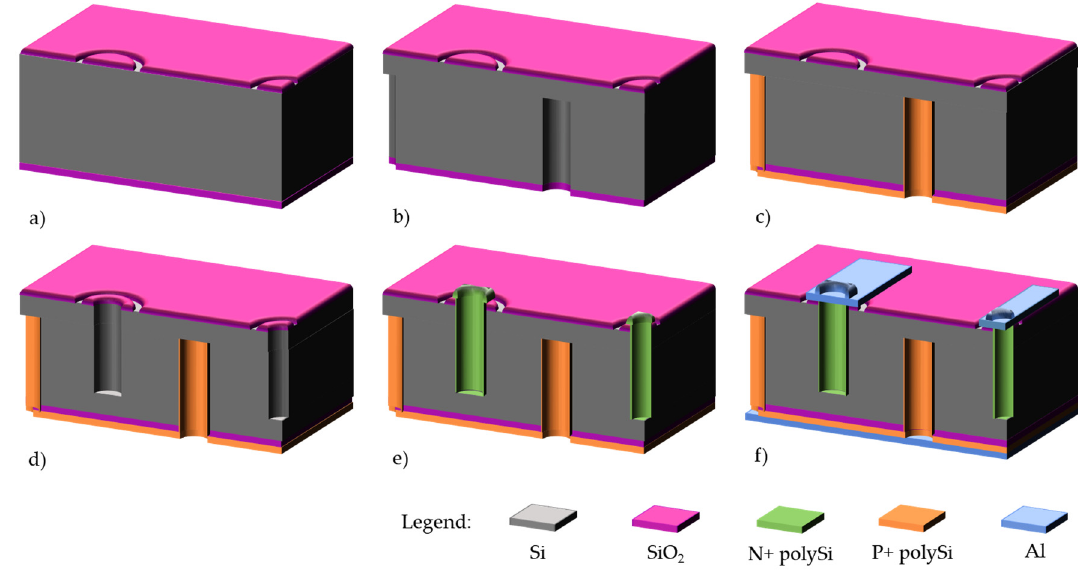
Figure 11. Double-side process at IMB-CNM on p-type wafers: ( a ) field oxidation and p-stop definition; ( b ) p + window patterning and DRIE of p + electrodes on backside; ( c ) polysilicon deposition and p + doping; ( d ) n + window patterning and DRIE of n + electrodes on front side; ( e ) polysilicon deposition and n + doping; ( f ) front and backside metallization and patterning. Passivation and temporary metal are not represented for